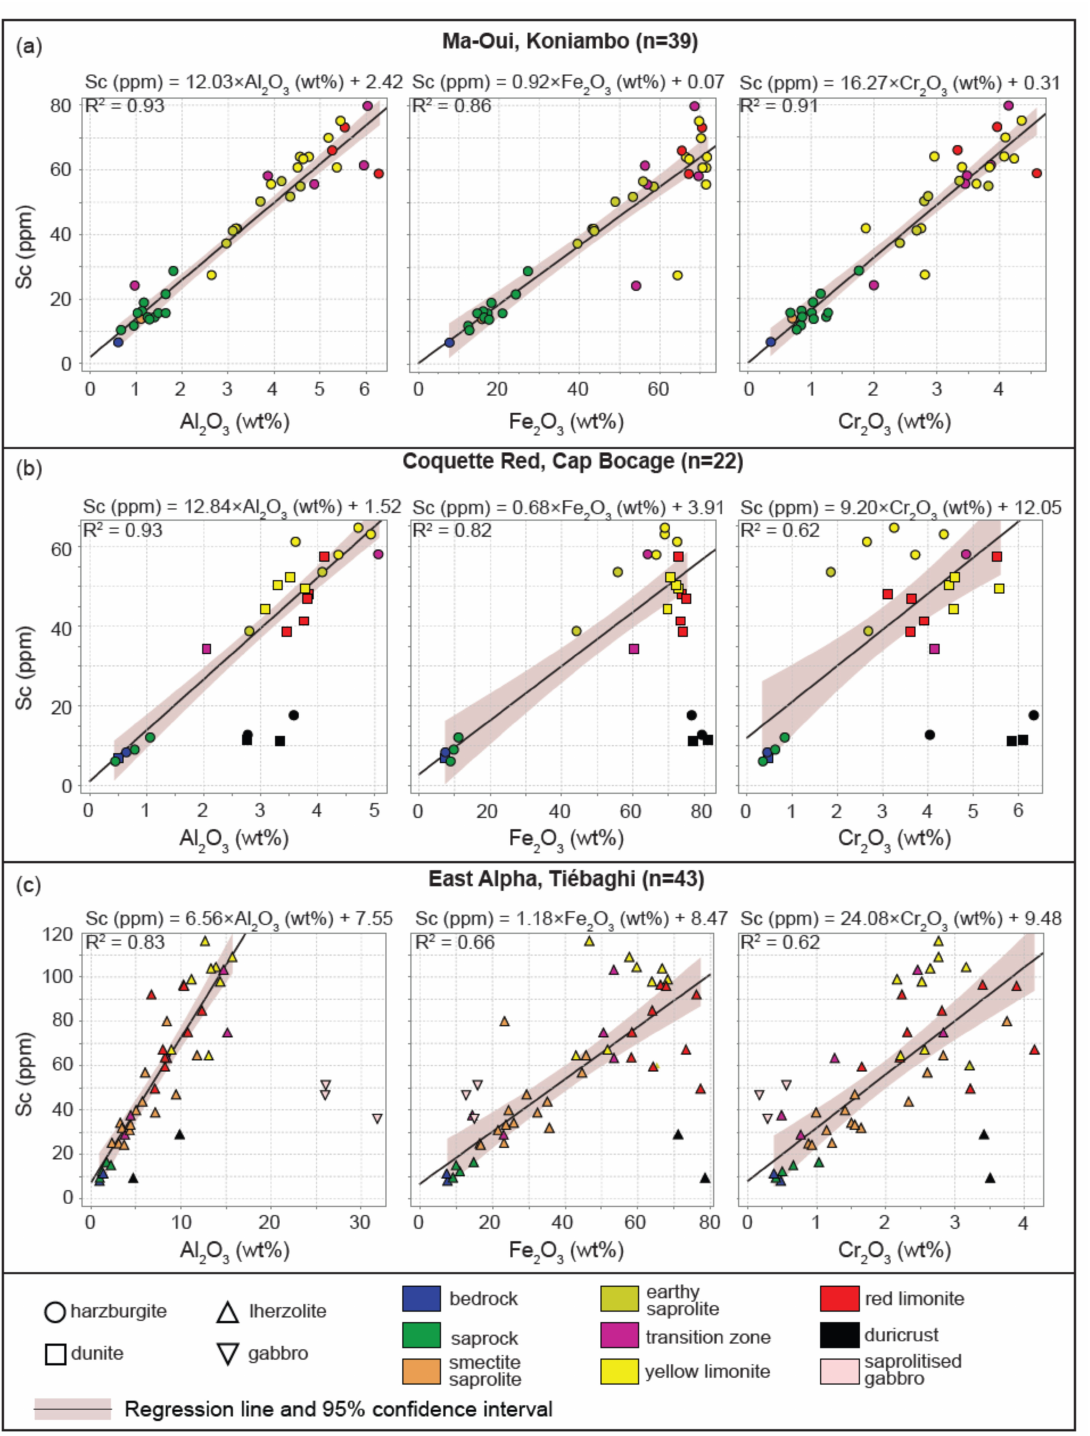
Figure 5. Sc-Al 2 O 3 , Sc-Fe 2 O 3 , and Sc-Cr 2 O 3 scatter plots and regression lines obtained for samples collected at ( a ) the Ma-Oui deposit (Koniambo massif), ( b ) the Coquette Red tenement (Cap Bocage massif), and ( c ) the East Alpha deposit (Ti é baghi massif). Peridotite-derived duricrust and gabbro- derived saprolite samples lie out of the correlation trends and are therefore excluded from the regression line